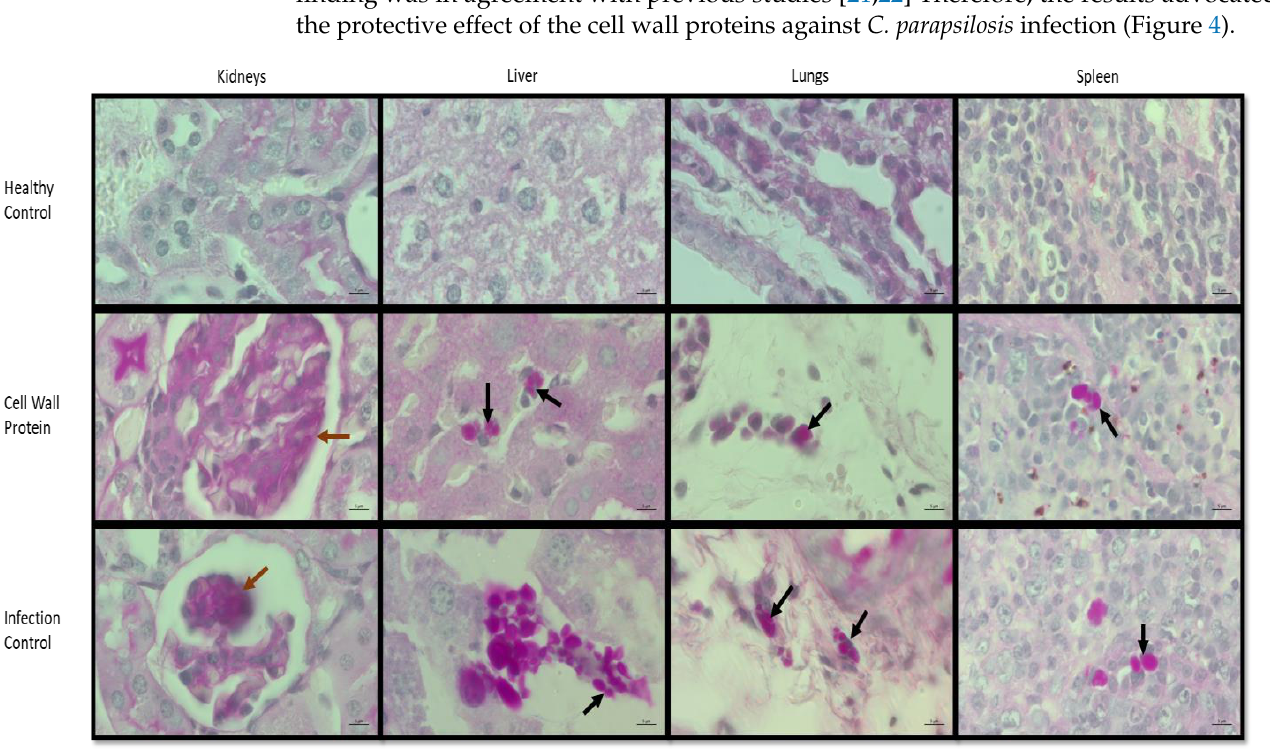
Figure 3. Analysis of fungal burden. The effect of cell wall protein extract against infection caused by C. parapsilosis . The fungal burden was expressed as geometric means of logarithmic values for CFU/mg of tissues. HC = health control; CWP = cell wall protein; IC = infection control. (*** p < 0.05).